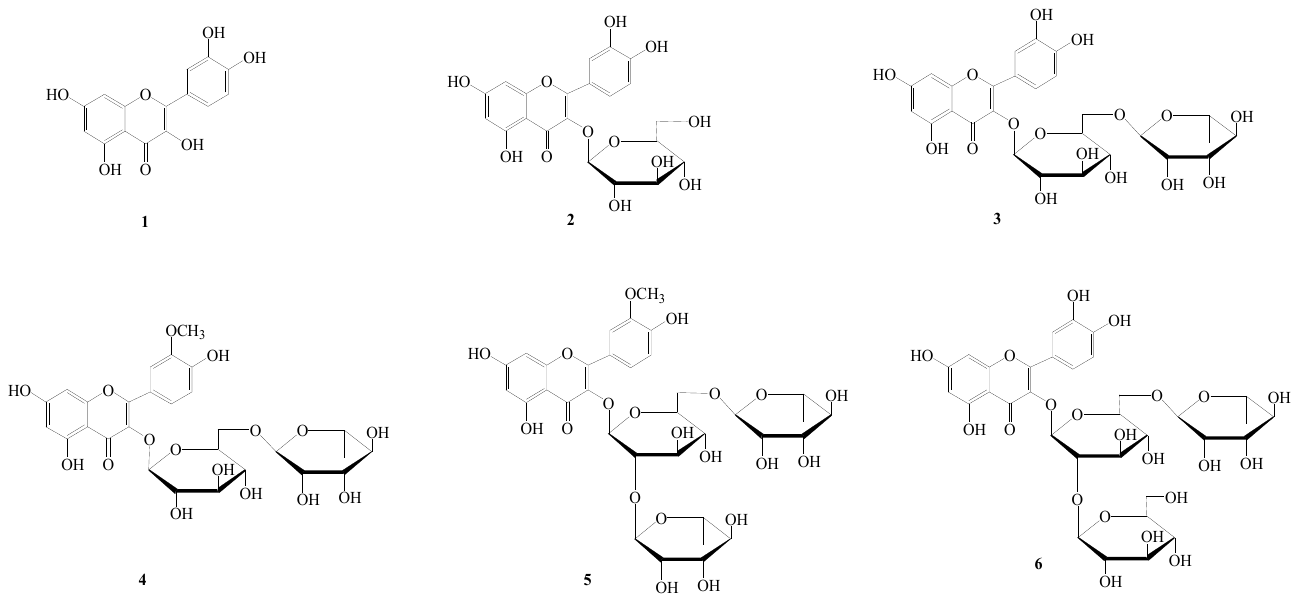
Figure 1. Chemical structures of compounds 1 – 6